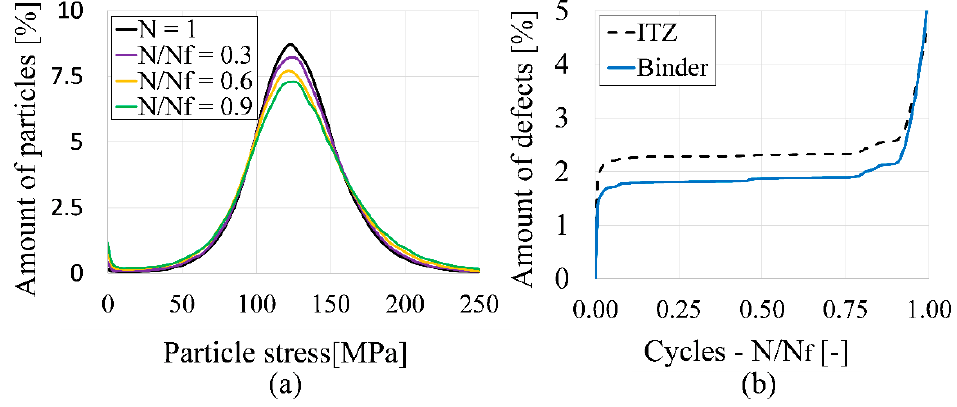
Figure 12. Evaluation of particle stresses and bond failure of the mesoscale model: ( a ) Particle stress distributions of binder particles at different fatigue stages; ( b ) Comparison of ITZ and binder bond failure.